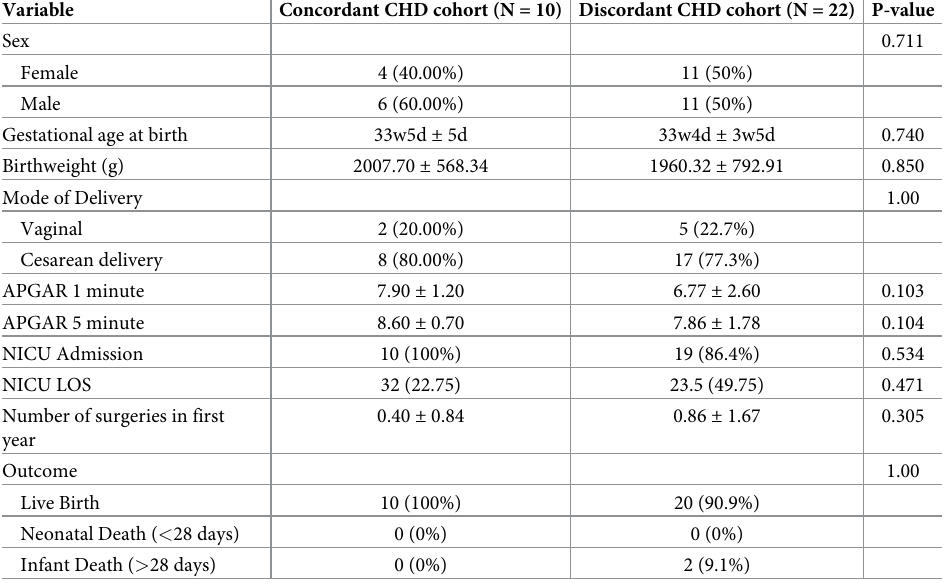
demographic and pregnancy outcomes. The spectrum of CHD described in this study includes septal defects, systemic venous anomalies, right heart lesions, left heart lesions, transposition of the great arteries (TGA), and thoracic arteries/veins, with the most common lesions in both Table 7. Neonatal outcomes and clinical details in concordant and discordant CHD groups for affected neonates